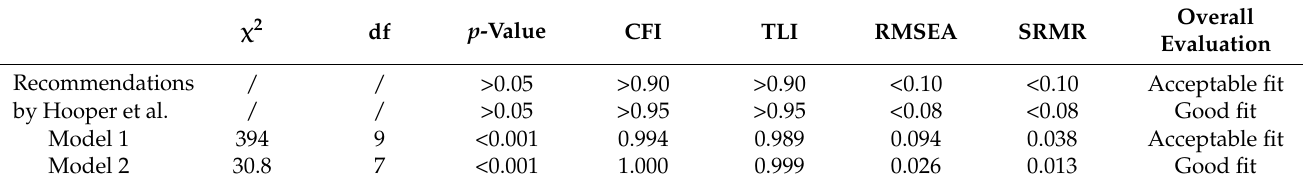
Table 4. Goodness-of-fit indices and evaluations for the two models.